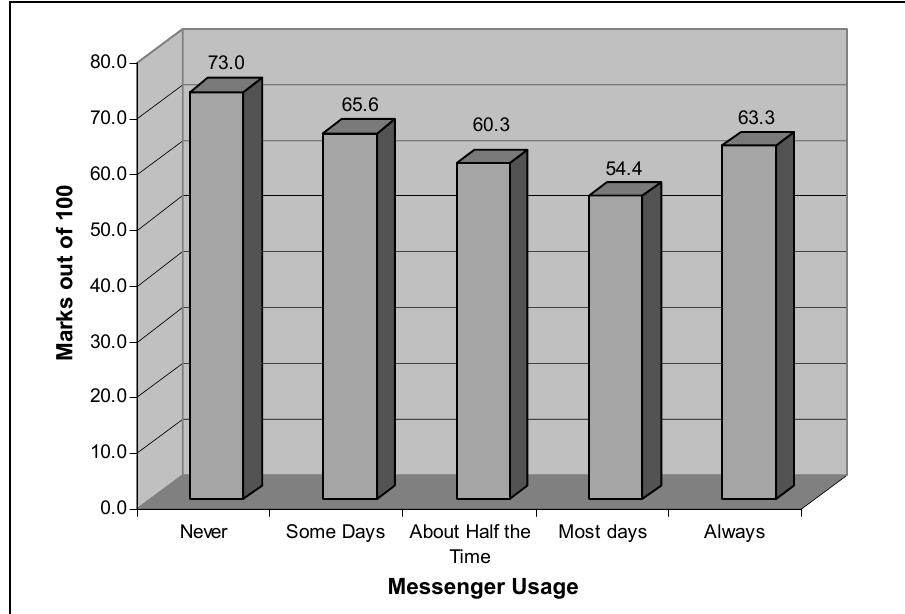
Figure 2. The averaged marks of two modules compared with student use of